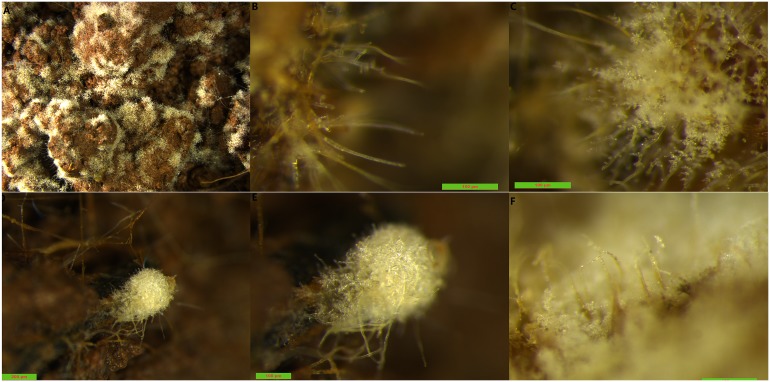
Morphologies of mycelia and sclerotia on the soil surface under stereomicroscope.(A~C) The morphology of mycelia under 1x, 16x, and 16x magnification of a zoom stereomicroscope, respectively; (D~F) The morphology of sclerotia under 5x, 10x, and 16x magnification of a zoom stereomicroscope, respectively. The morphology of mycelia and sclerotia between medium and soil showed significantly different.